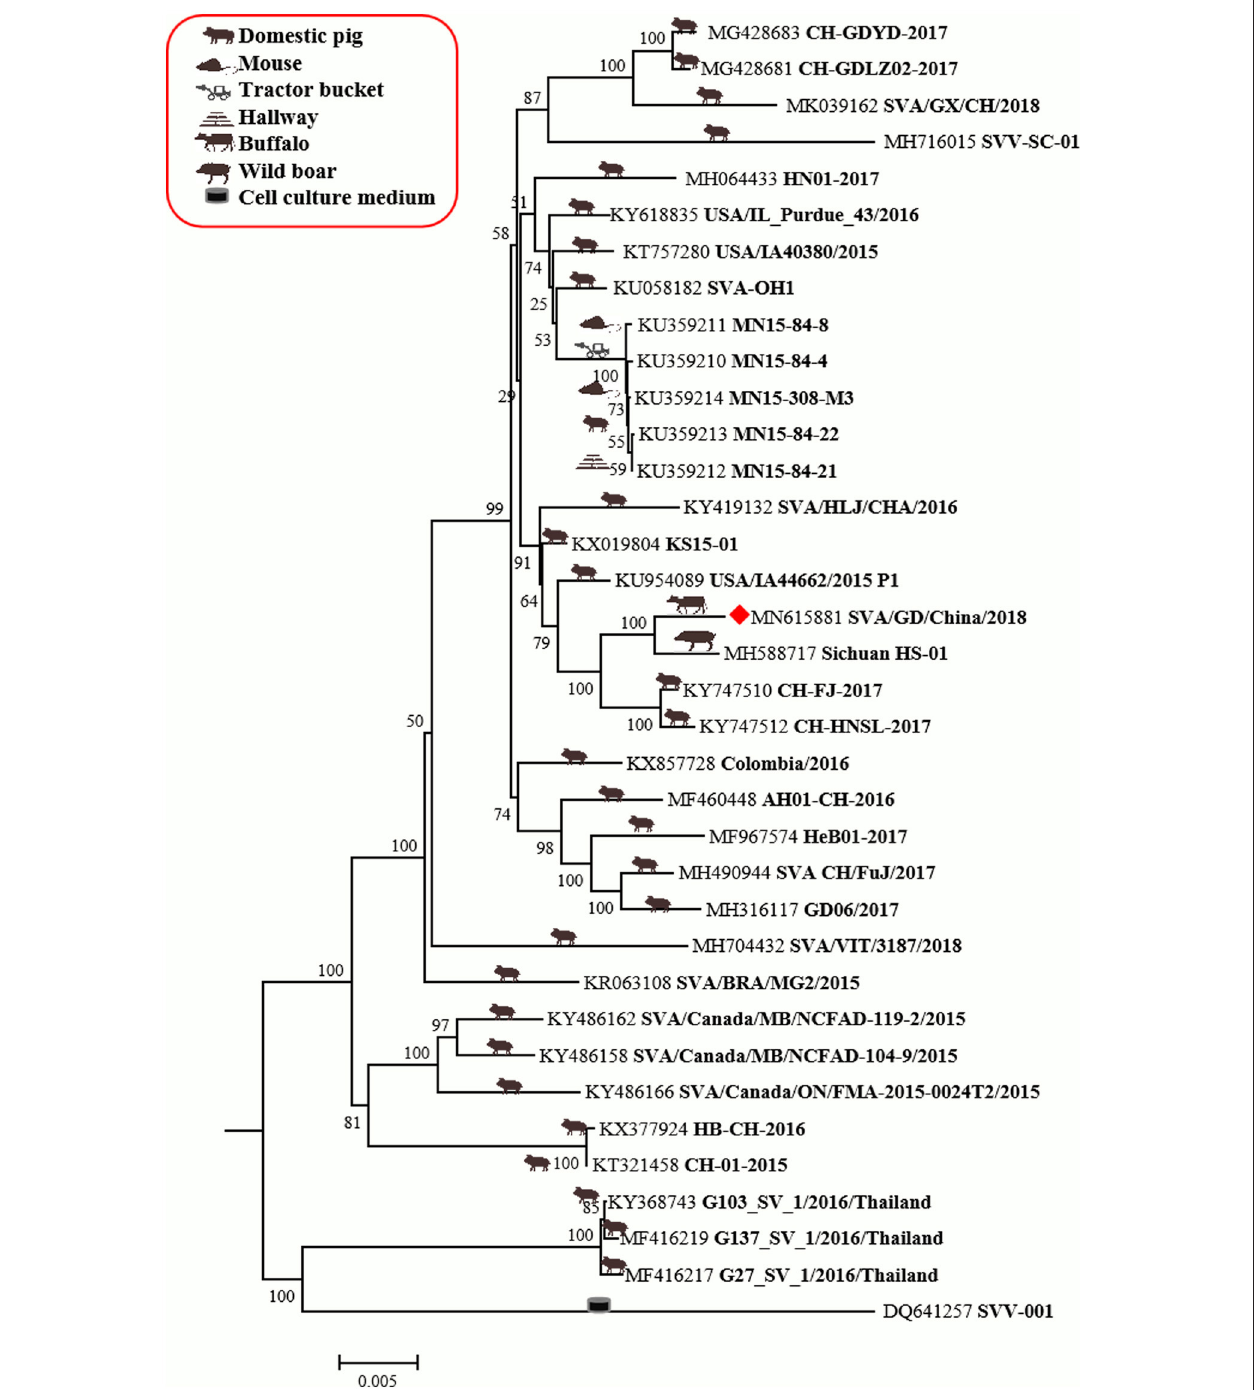
FIGURE 2 | The phylogenetic analysis of SVV based on polyprotein nucleotides. Neighbor-joining tree generated with 1,000 bootstrap samplings (MEGA 6.06). The diamond shape represents the strain in this study. The icon before the accession number indicates the host source of the sequence. At present, only SVA/GD/China/2018 has been derived from diseased buffalo and is in the same branch and closely related to the wild boar-origin strain, Sichuan HS-01.